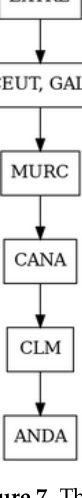
Table 10. Comparison between our result (ELECTRE III with all weights equal to 1 and no thresholds) and INE result (arithmetic mean).